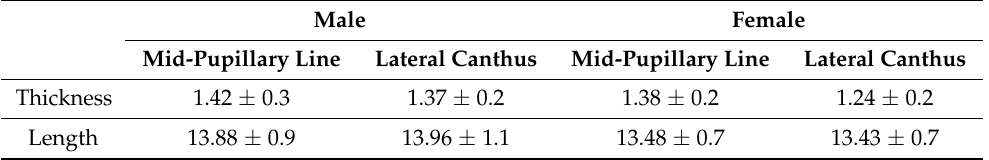
Table 2. ROOF distances and thicknesses using ultrasound.